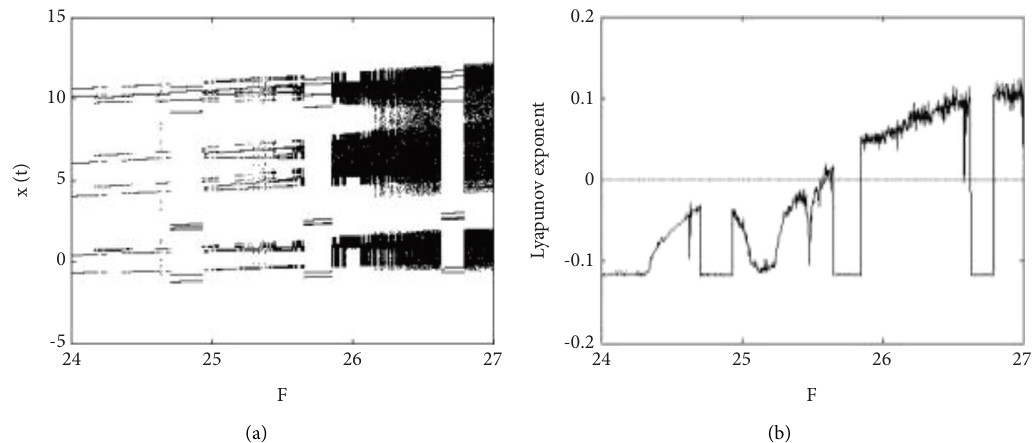
Figure 4: Bifurcation diagram (a) and Lyapunov exponent (b) versus the amplitude force ratio. Te other parameters are ξ � 0 . 1, ω � 1 . 35, and α � 1. It appears a perfect correspondence between the two